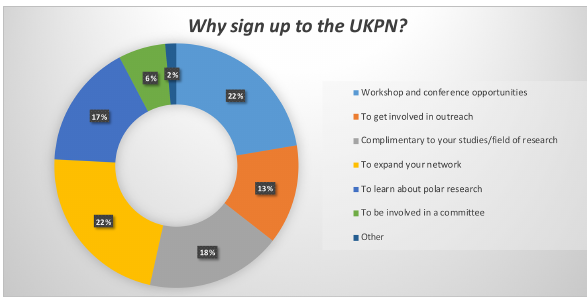
Figure 4. Survey results on why members joined the UK Polar Net- work.